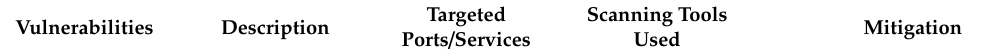
Table 1. Onion Omega2 vulnerability and mitigation (vendor fixes).